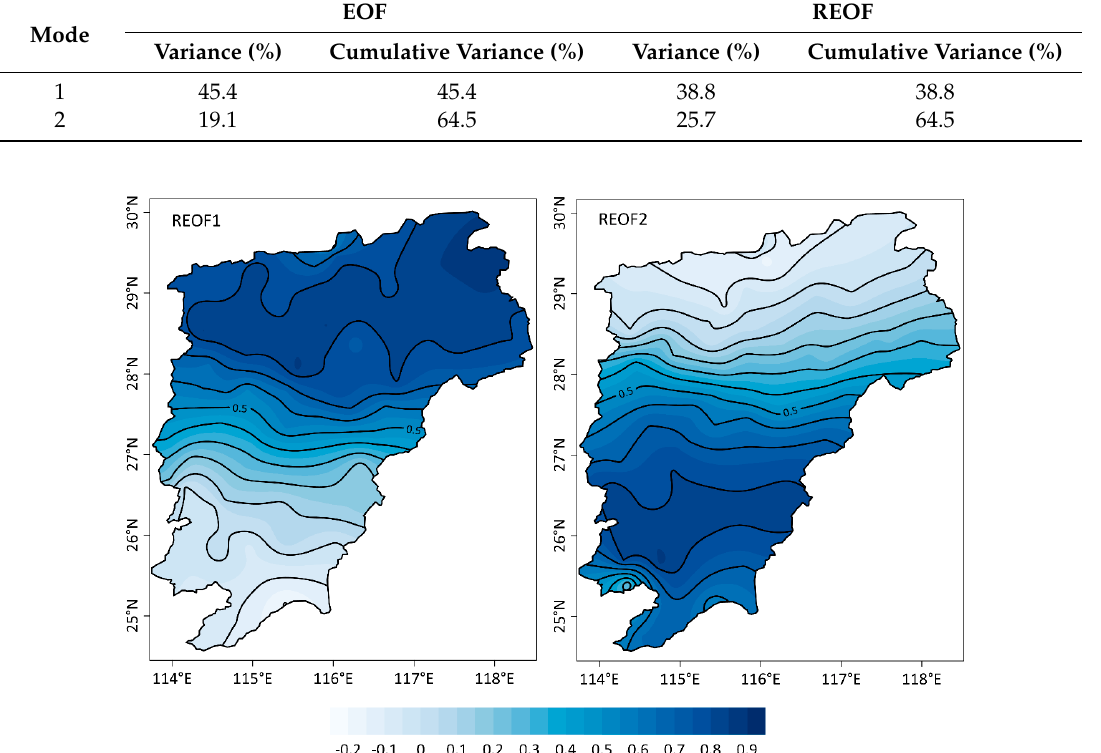
Figure 2. The two leading REOF modes of summer precipitation in the Poyang Lake basin (PYLB).